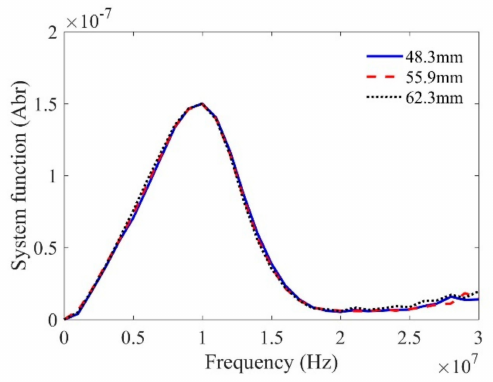
Figure 5. Reference signals reflected from the front surface for calibrating the system function. Time is shifted for comparison.